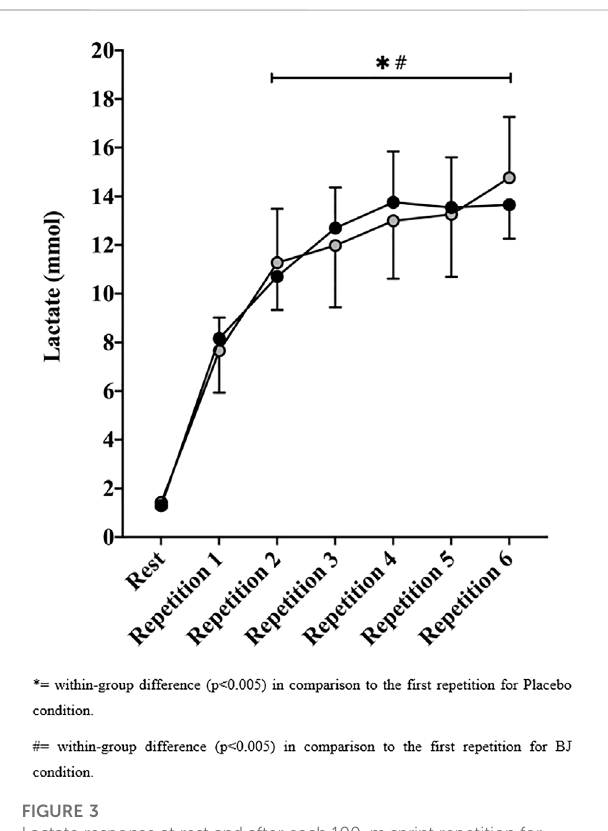
FIGURE 3 Lactate response at rest and after each 100-m sprint repetition for the beetroot juice (BJ) and placebo